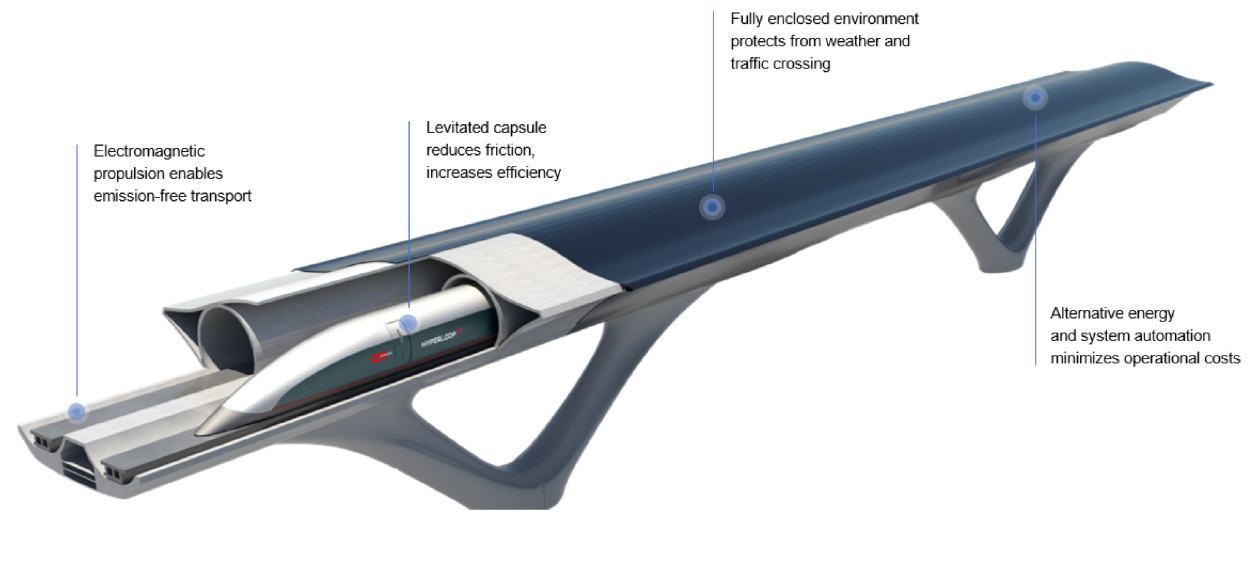
Figure 1. Hyperloop TT system.